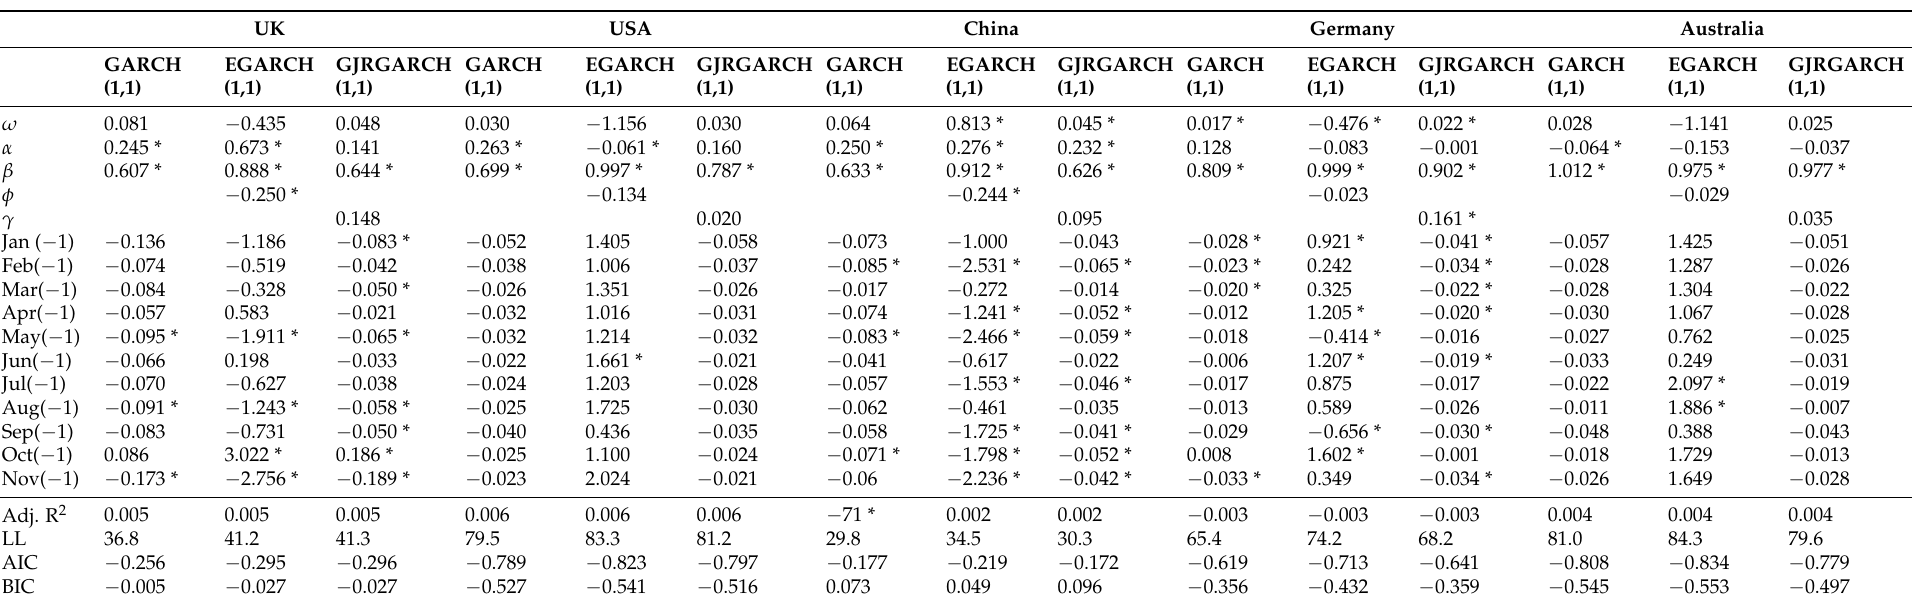
Table 8. Conditional variance equation (selective five